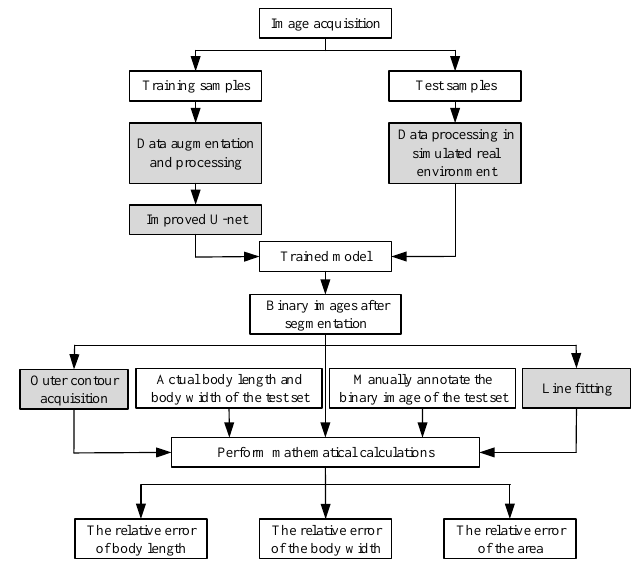
Figure 3. The system flow chart of the proposed measurement